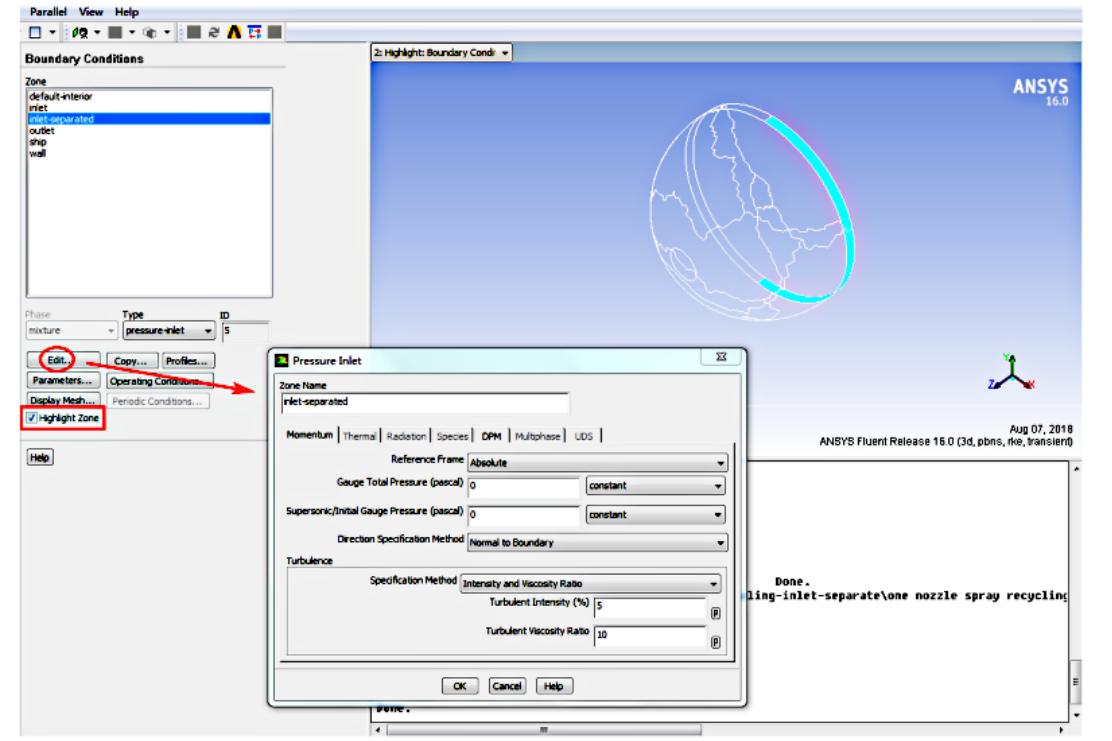
Figure 12. Condition setting for inlet-separated boundaries of single-layer spherical recovery hoods.